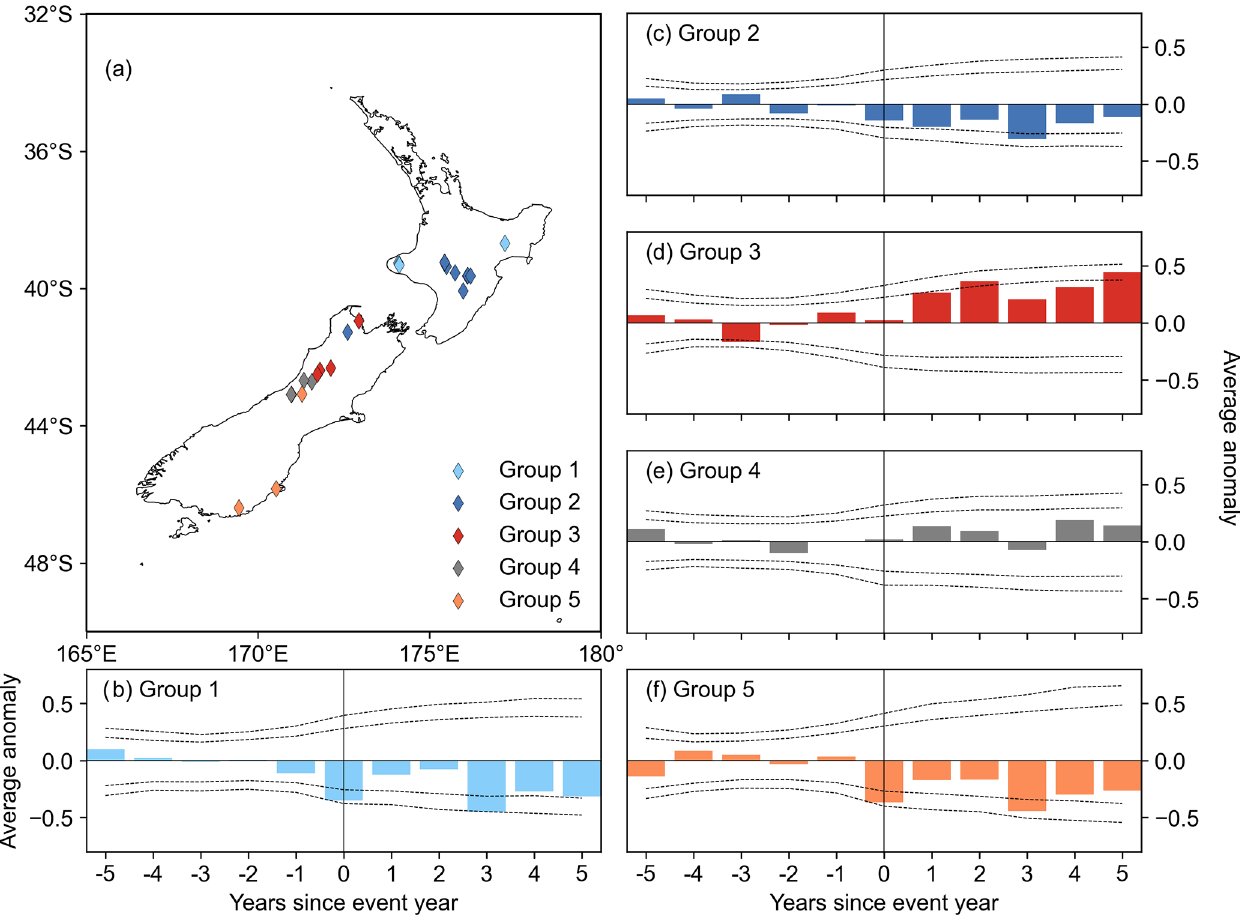
Figure 4. (a) Results of k -means clustering of New Zealand cedar chronologies. (b–f) Mean chronology departures 5 years before and after eruption years (year 0), separated by cluster, and the 95th and 99th significance levels calculated by generating 10000 random samples of non-event years from the group composite. The map in (a) was made with Natural Earth free vector map data, which are available at http://naturalearthdata.com (last access: 17 November